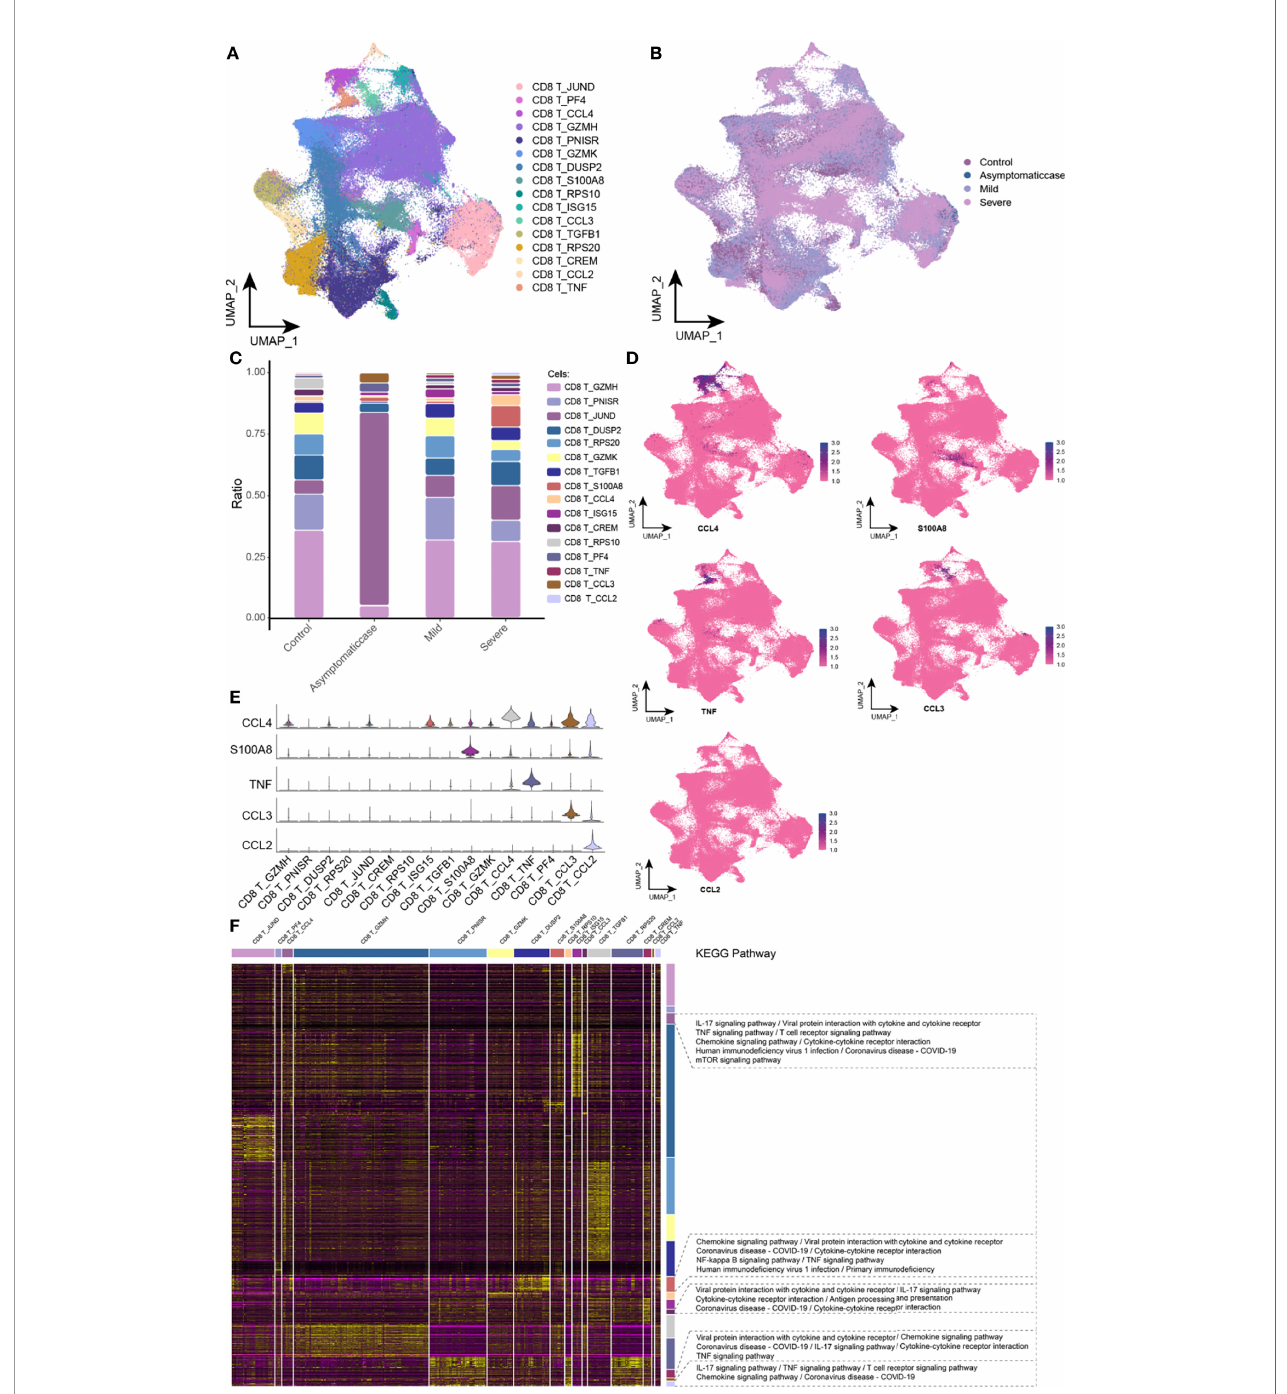
FIGURE 4 | Abnormal components of CD8 T cell in patients with COVID-19. (A) Single-cell mapping of CD8 T cell subsets. (B) Single-cell mapping of CD8 T cells in the COVID-19 courses. (C) Components and changes in CD8 T cell subsets in the COVID-19 courses. (D, E) Expression of marker genes in CD8 T cell subsets. (F) CD8 T cells with speci fi c changes in subsets involved in biological pathways. KEGG, Kyoto Encyclopedia of Genes and Genomes; UMAP, Uniform Manifold Approximation and Projection for Dimension